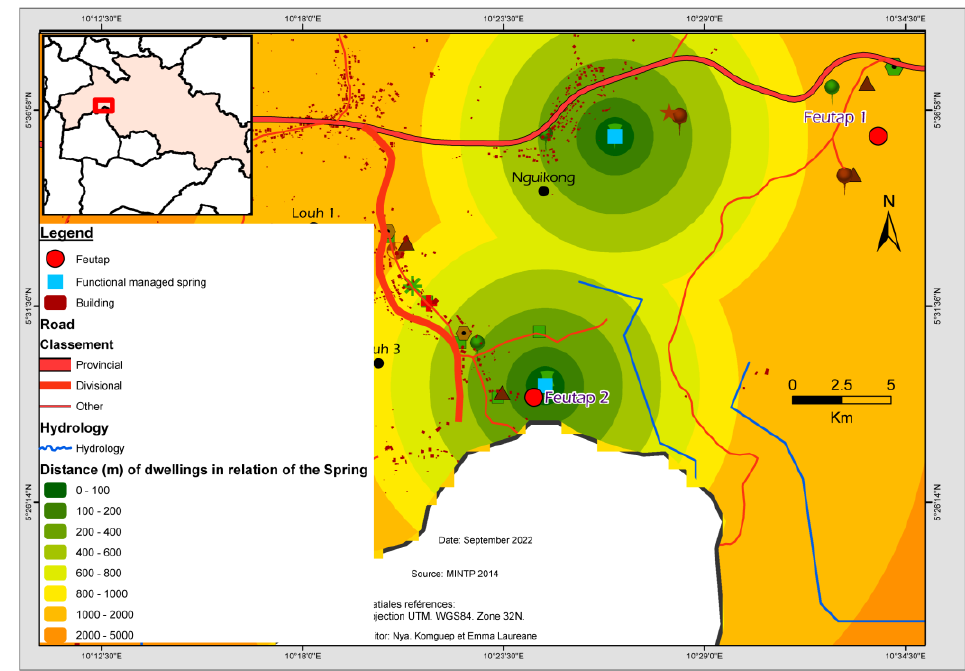
Figure 3. Distance (m) between spring and houses in Feutap village.